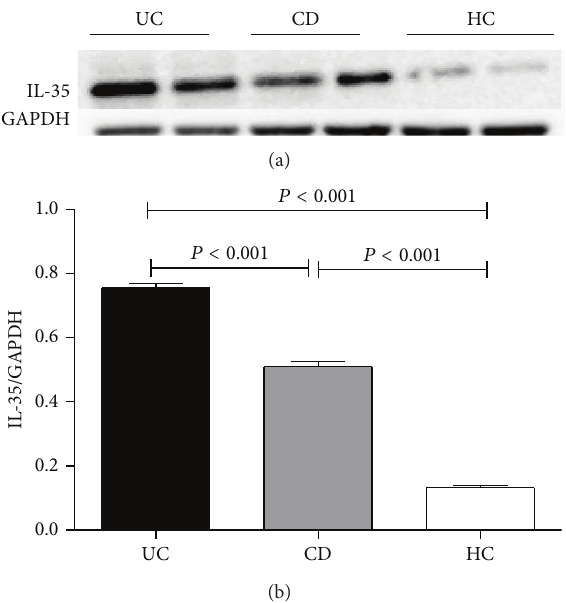
Figure 4: Detection of IL-35 in protein extracts of endoscopic specimens by Western blot. Representative Western blot of IL- 35 and GAPDH (a) proteins levels in UC and CD patients and healthy controls. A significant upregulation of IL-35 was observed in inflamed mucosa of patients as compared to controls ( 𝑃 < 0.001 ) and IL-35 protein expression in UC biopsies was higher than that in CD biopsies